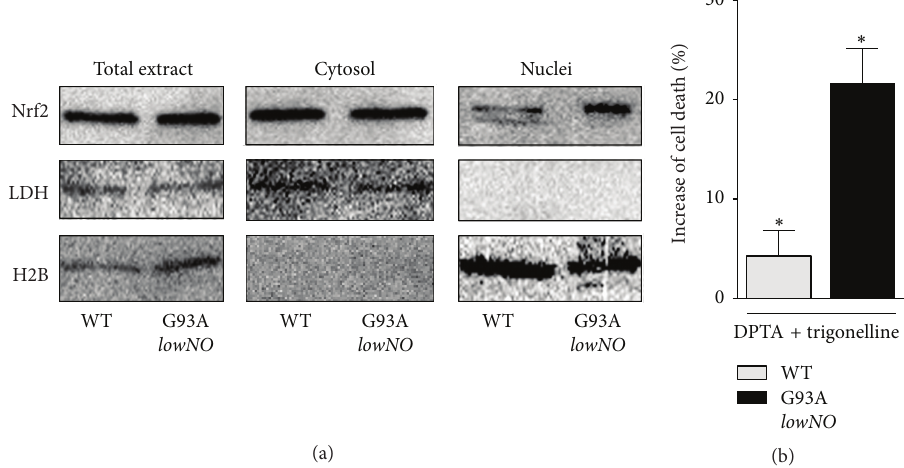
Figure 8: Role of Nrf2 in the lowNO G93A resistant clone. (a) Western blot analyses of Nrf2 in nuclear and cytosolic fractions obtained from parental SH-SY5Y (WT) and the lowNO G93A clone. (b) Cytofluorimetric analyses of apoptosis upon propidium iodide staining performed on parental SH-SY5Y cells (WT) and the lowNO G93A clone treated for 24 with DPTA in the presence or absence of the Nrf2 inhibitor trigonelline (0.5 𝜇 M). Western blots shown are representative of at least 𝑛 = 3 independent experiments that gave similar results. Lactate dehydrogenase (LDH) and histone H2B were selected as loading and purity controls. Graphs shown represent the mean of data ± SD of 𝑛 = 3 independent